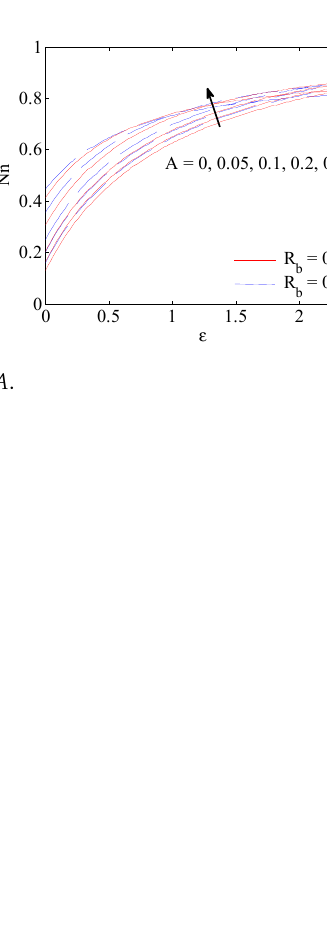
Figure 8. Fluctuations of θ due to the factor W e